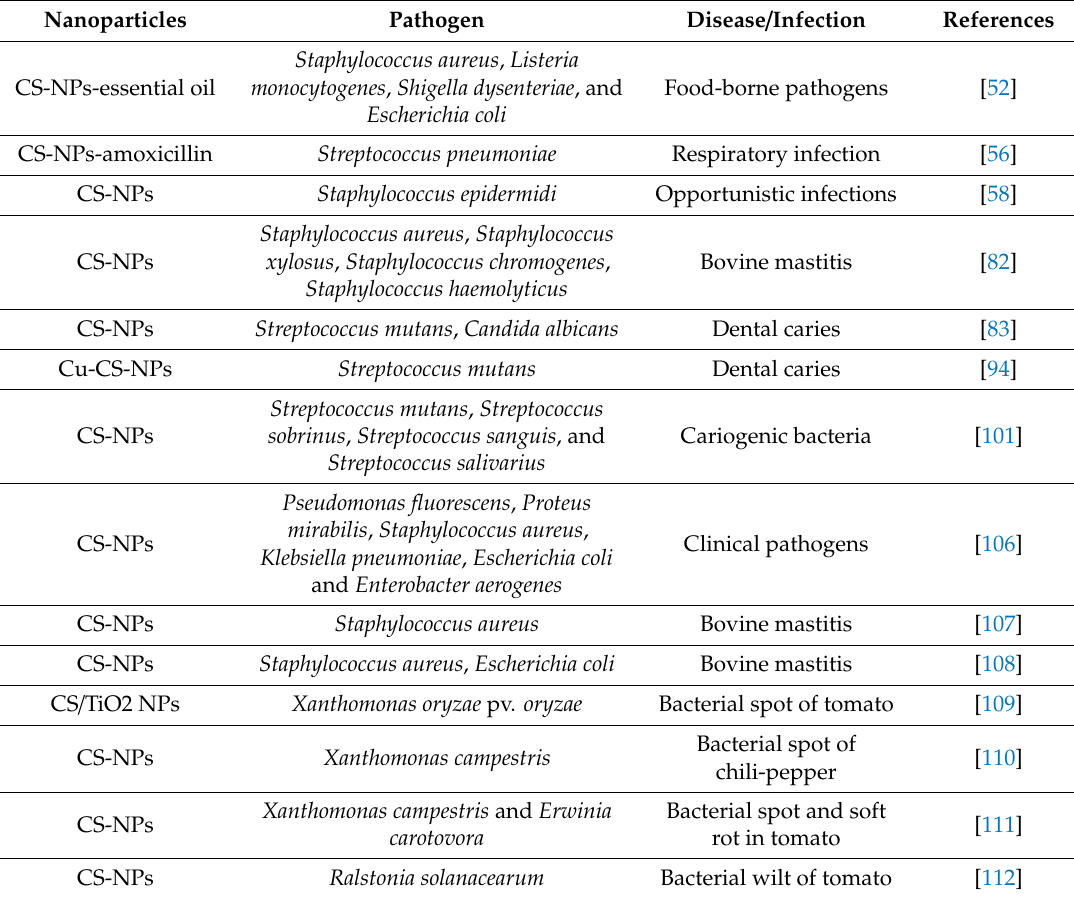
Table 3. Antibacterial activity of chitosan nanoparticles and their derivatives against animal and plant